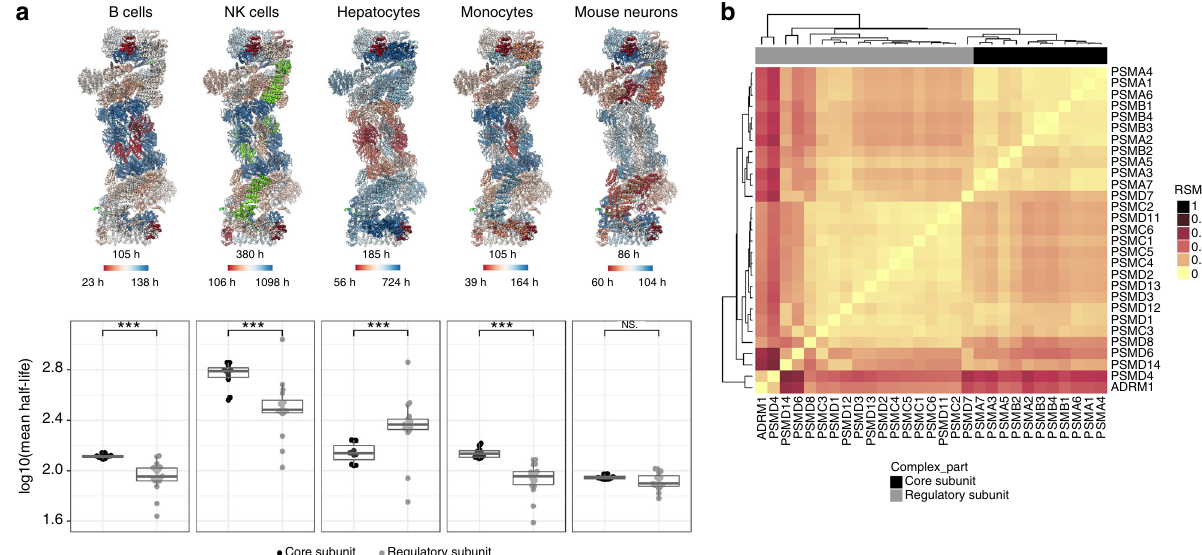
Fig. 4 Architecture-dependent turnover of the proteasome subunits. a Upper panel: proteasome subunits are shown color-coded as gradient from red (short half-life) to blue (long half-life). For each cell type, half-lives were averaged over biological replicates, except for rare cases where only one half-life value was available, and converted to a color gradient as explained in the Methods. The median, minimum, and maximum half-lives are indicated together with the color bars. Subunits with undetermined half-lives are colored green. Lower panel: distributions of the reproducibly measured half-lives of the regulatory and the non-exchangeable core subunits of the proteasome in the different cell types. Differences in the distributions of log 10 half-lives were assessed by Wilcoxon-rank test (signi fi cance levels were encoded as *** p < 0.001, ** p < 0.01, * p < 0.05). Center line in box plots is the median, the bounds of the boxes are the 75 and 25% percentiles i.e., the interquartile range (IQR) and the whiskers correspond to the highest or lowest respective value or if the lowest or highest value is an outlier (greater than 1.5 * IQR from the bounds of the boxes) it is exactly 1.5 * IQR b Heatmap showing the comparison for each pair of proteasome subunits by calculating the root mean square error between their four log 10 transformed half-lives in the four different human cell types. Hierarchical clustering leads to separation of the regulatory subunits from the non-exchangeable core subunits. The 19S proteasome subunits PSMD4 and the recently discovered ADRM1 form a distinct